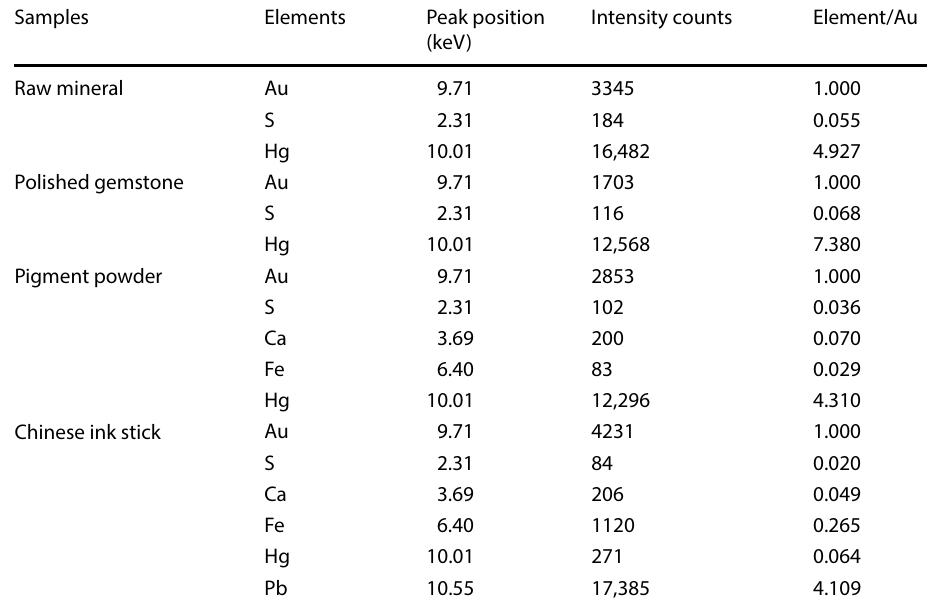
Table 2 Peak intensity counts obtained from portable XRF